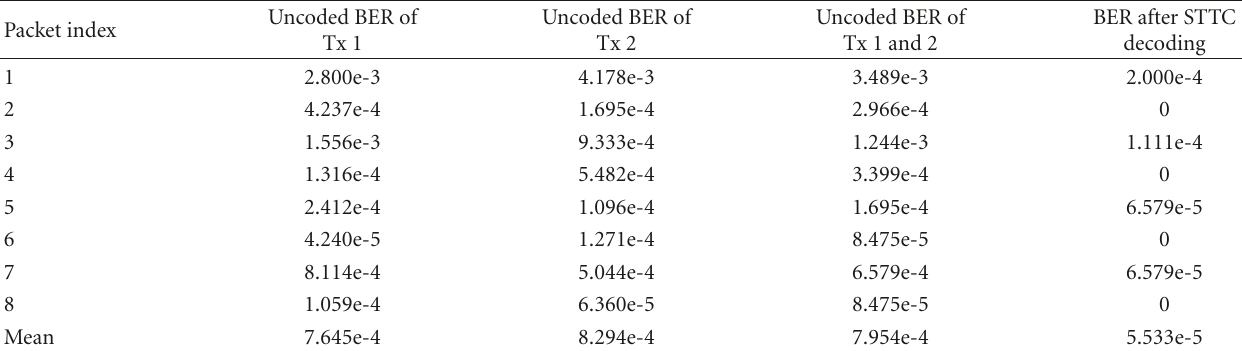
Figure 7: Partition of the transmitted data payload for block detection at the receiver (the same structure applied to all N transmission streams). Table 1: BER of LB 2 × 8 MIMO with BPSK